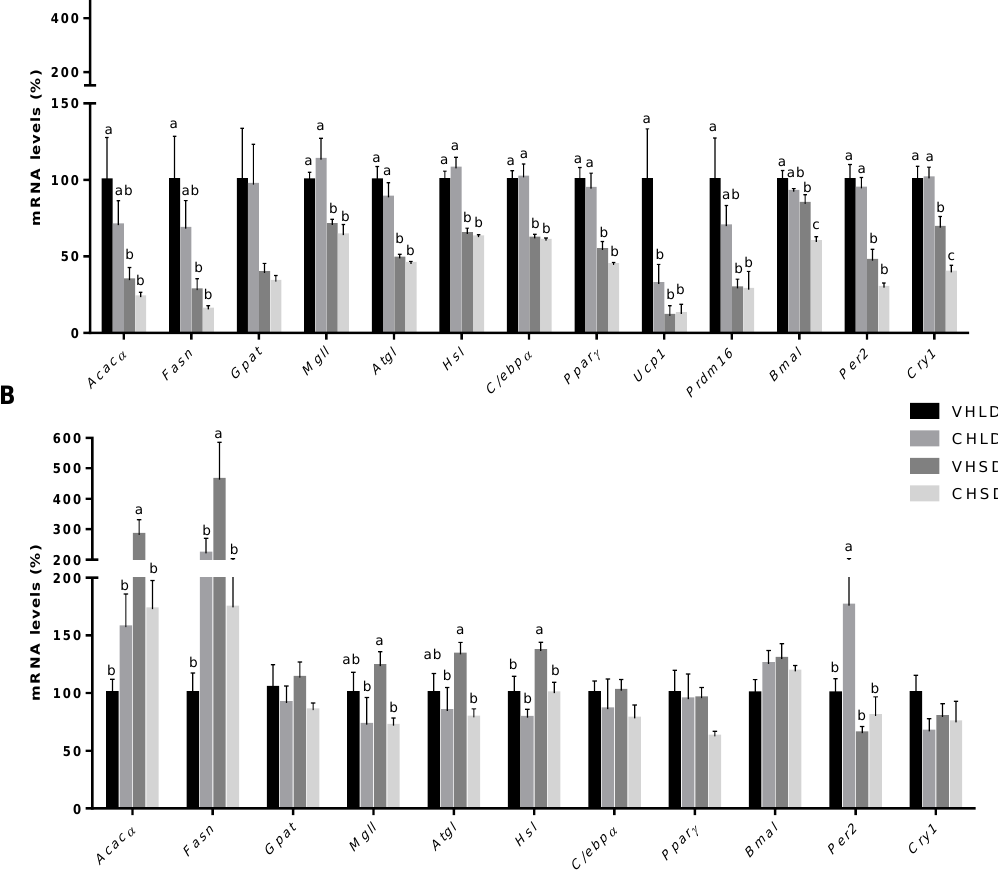
Figure 2. mRNA expression levels in RWAT of Fischer 344 rats supplemented with a cherry (CH) lyophilizate or vehicle (VH), held in long-day (LD) and short-day (SD) photoperiods, and fed either with a standard (STD) ( A ) or a cafeteria (CAF) ( B ) diet in two independent experiments. Expression of genes related to lipogenesis, lipolysis, adipogenesis, thermogenesis, and the molecular clock. Data are presented as the ratios of gene expression relative to β -actin , Ppia , and Hprt genes and expressed as a percentage of the LD group set at 100%. Data are presented as the mean ± SEM, and the four groups were compared with a one-way ANOVA test ( p < 0.05) followed by a Duncan’s new multiple range test (MRT) post hoc test. abc Mean values with unlike letters differ significantly among